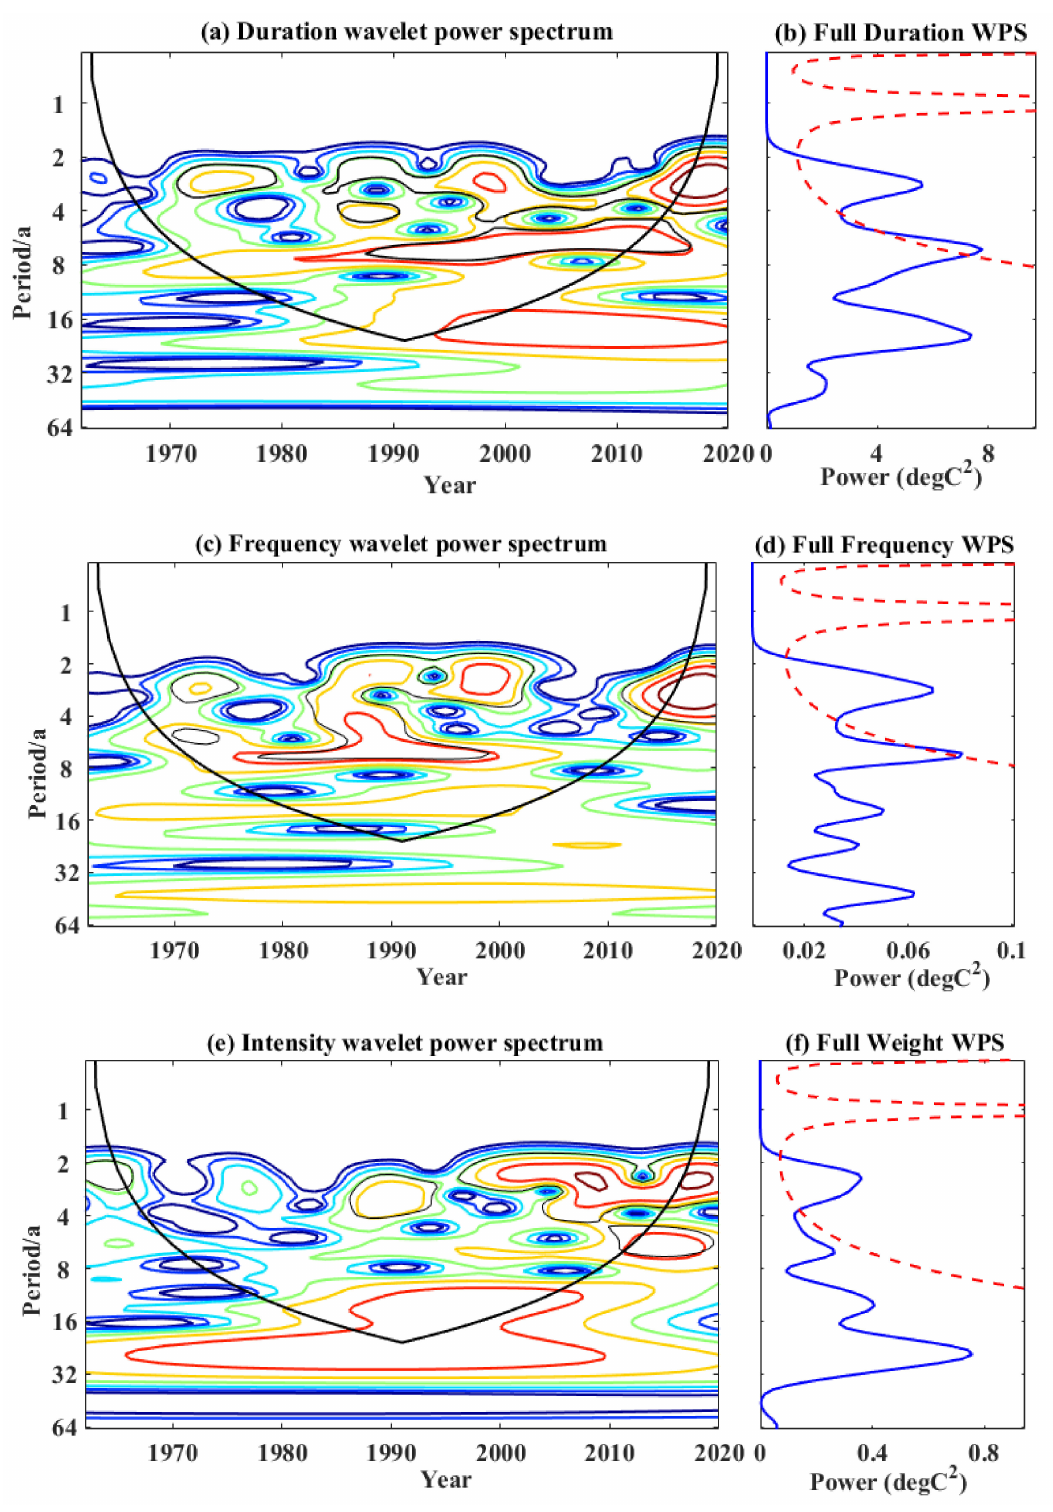
Figure 5. Wavelet power spectrum analysis of duration ( a , b ), frequency ( c , d ) and intensity ( e , f ) of heatwaves in Hexi